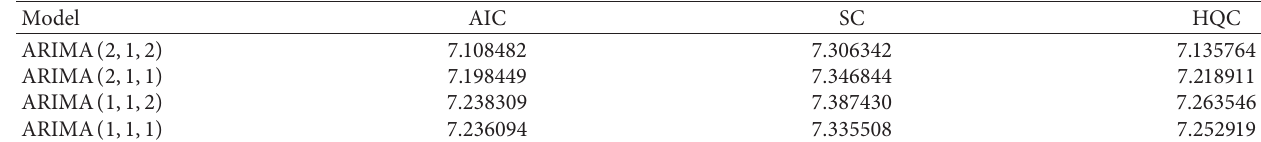
Table 4: AIC, SC, and HQC of different ARIMA